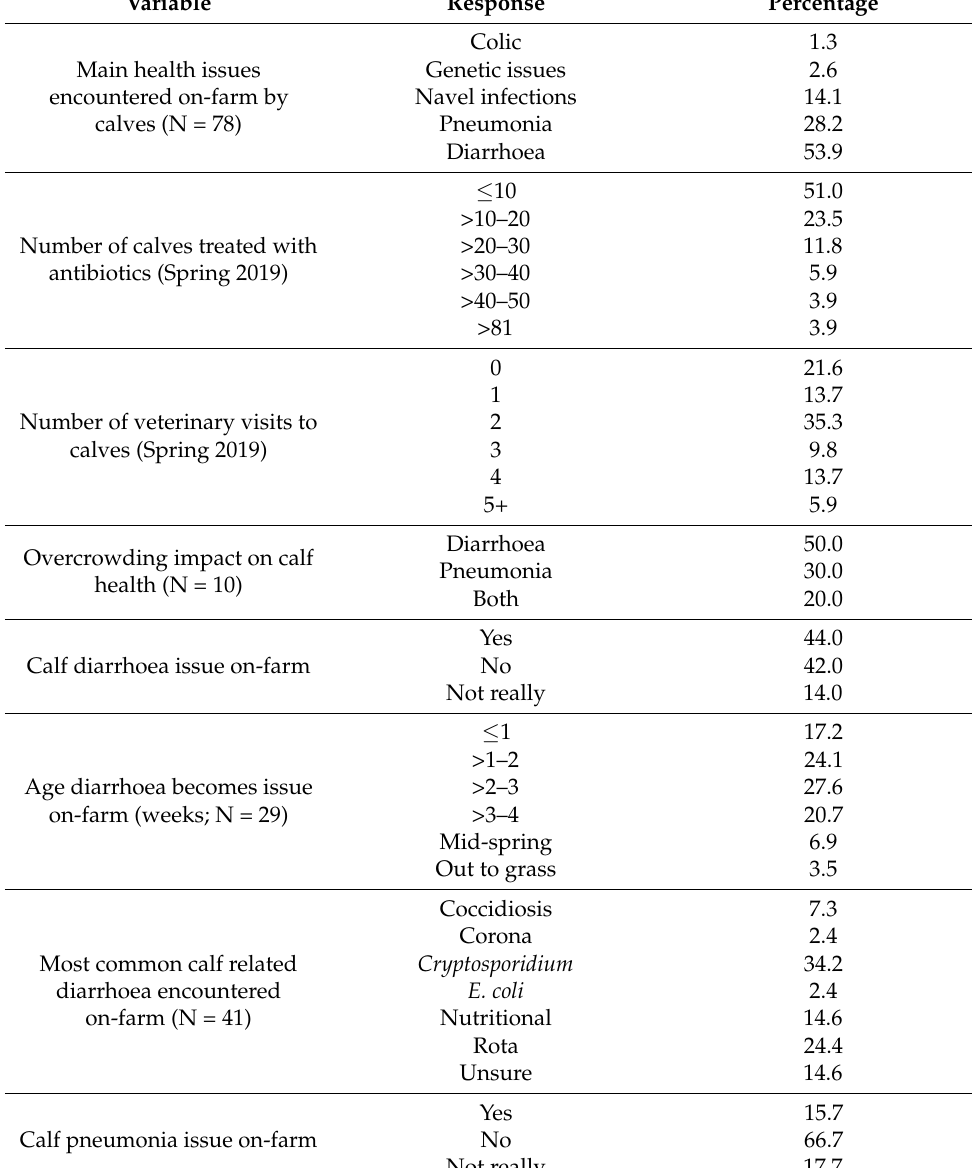
Table 6. Summary of farm calf health data based on producer reporting (N = 51 unless otherwise